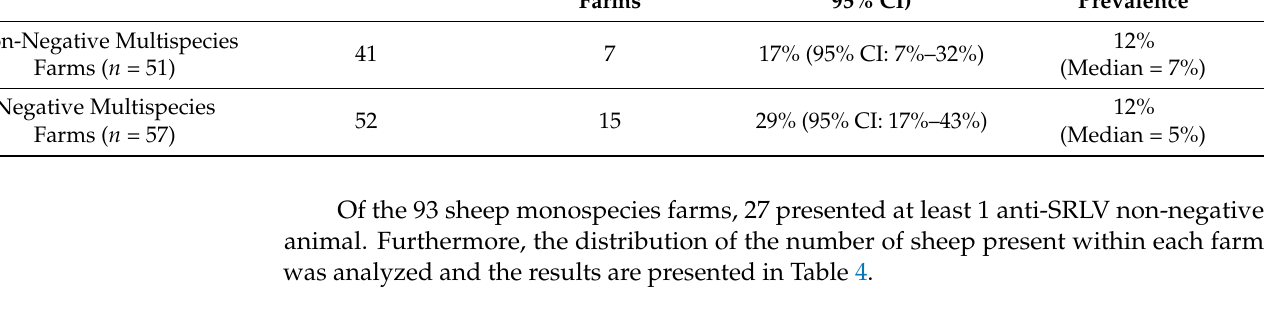
Table 4. Descriptive statistics of SRLV results for the 93 sheep monospecies